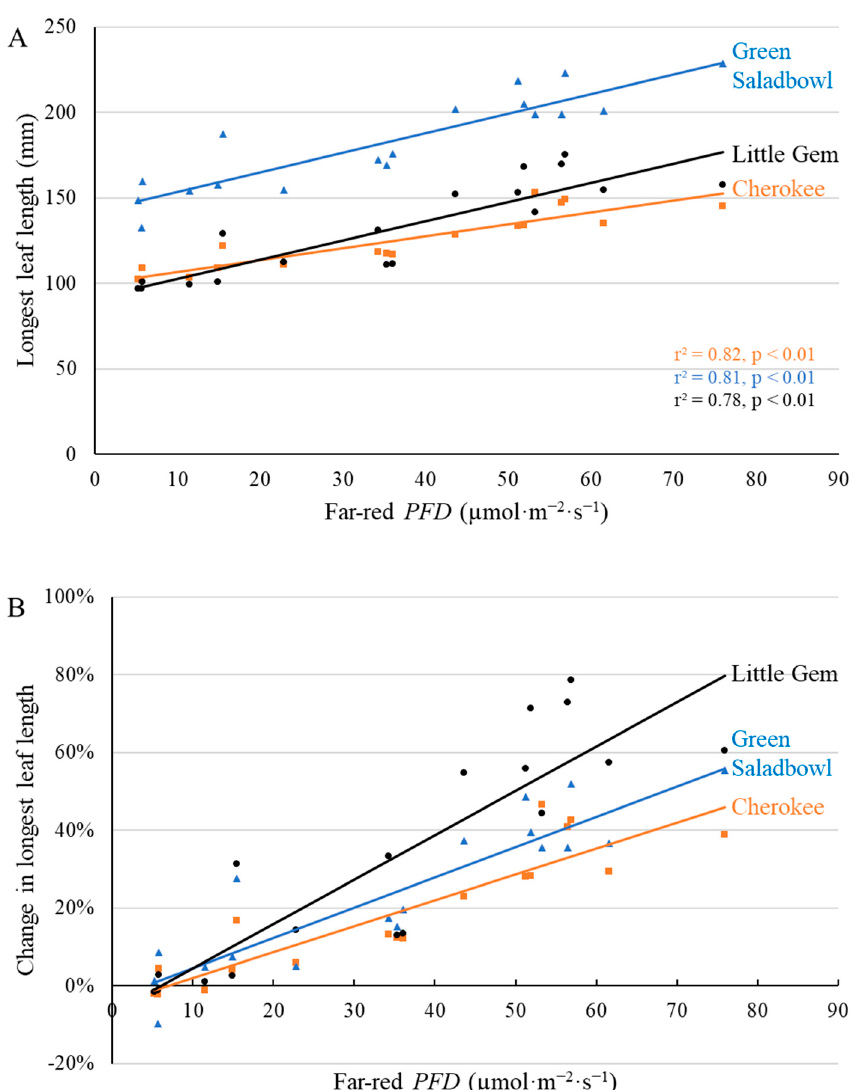
Figure 2. With a background of 204 µ mol · m − 2 · s − 1 white LED light, supplemental far-red photons linearly increased length of the longest leaf ( A ) and the relative change in length of the longest leaf (( B ), compared to plants under no supplemental far-red light) 20 days after the start of far-red light treatment for ‘Cherokee’, ‘Green Saladbowl’, and ‘Little Gem’ lettuce. The r 2 and p values for regression of each cultivar apply to both graphs and are shown with the respective color.